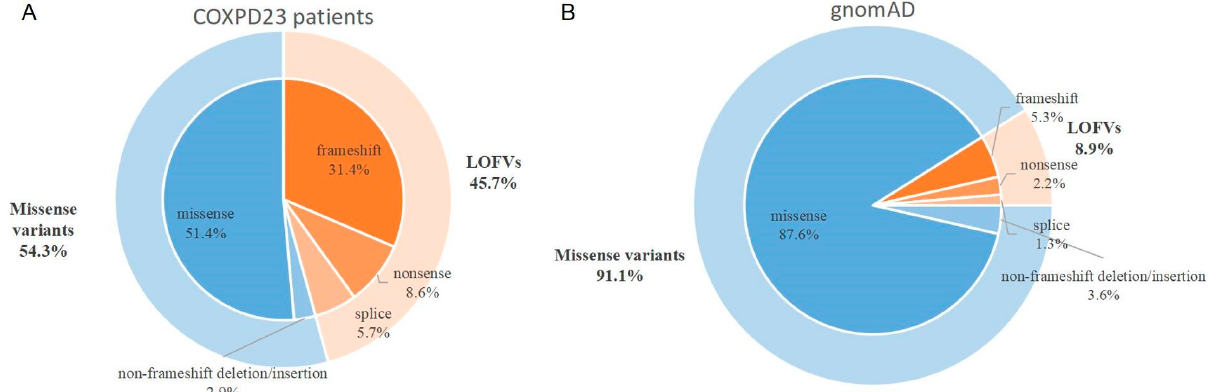
Figure 4. Proportions of different variant types in two groups. ( A ) COXPD23 patients ( n = 35) included 11 frameshift variants, 3 nonsense variants, 2 splice variants, 1 non-frameshift deletion, and 18 missense variants; ( B ) The general population in gnomAD ( n = 225) included 12 frameshift variants, 5 nonsense variants, 3 splice variants, 8 non-frameshift deletions/insertions, and 197 missense variants.